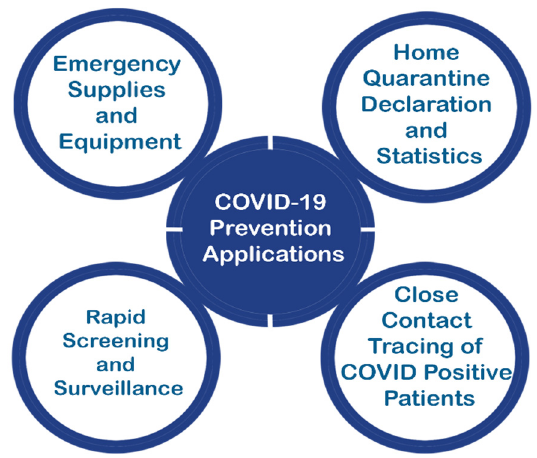
Figure 5. Proposed framework for prevention of spreading COVID-19.